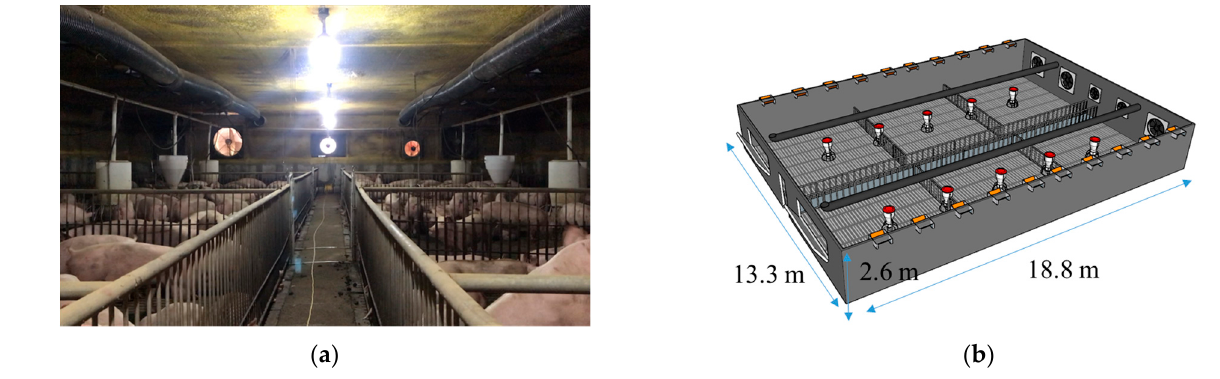
Figure 2. Experimental fattening pig house. ( a ) Inside the fattening pig house. ( b ) A schematic of the fattening pig house.